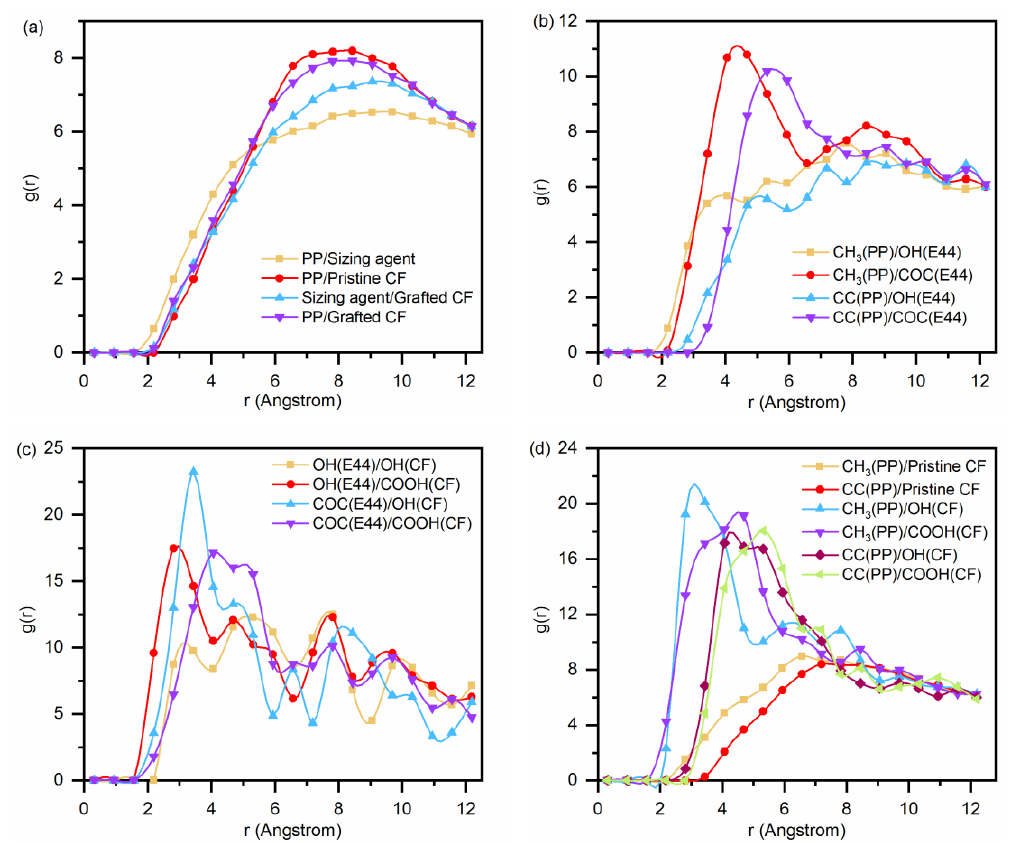
Figure 11. The RDFs for: ( a ) PP/sizing agent (S 60 ), PP/pristine CF (SR), sizing agent/grafted CF (S 60 ) and PP/grafted CF (S 0 ); ( b ) the active groups of PP/sizing agent(S 60 ); ( c ) sizing agent/active groups on the surface of CF (S 60 ); ( d ) CH 3 (PP)/Pristine CF (SR), CC(PP)/Pristine CF (SR), CH 3 (PP)/OH(CF) (S 0 ), CH 3 (PP)/COOH(CF) (S 0 ), CC(PP)/OH(CF) (S 0 ) and CC(PP)/COOH(CF) (S 0 )